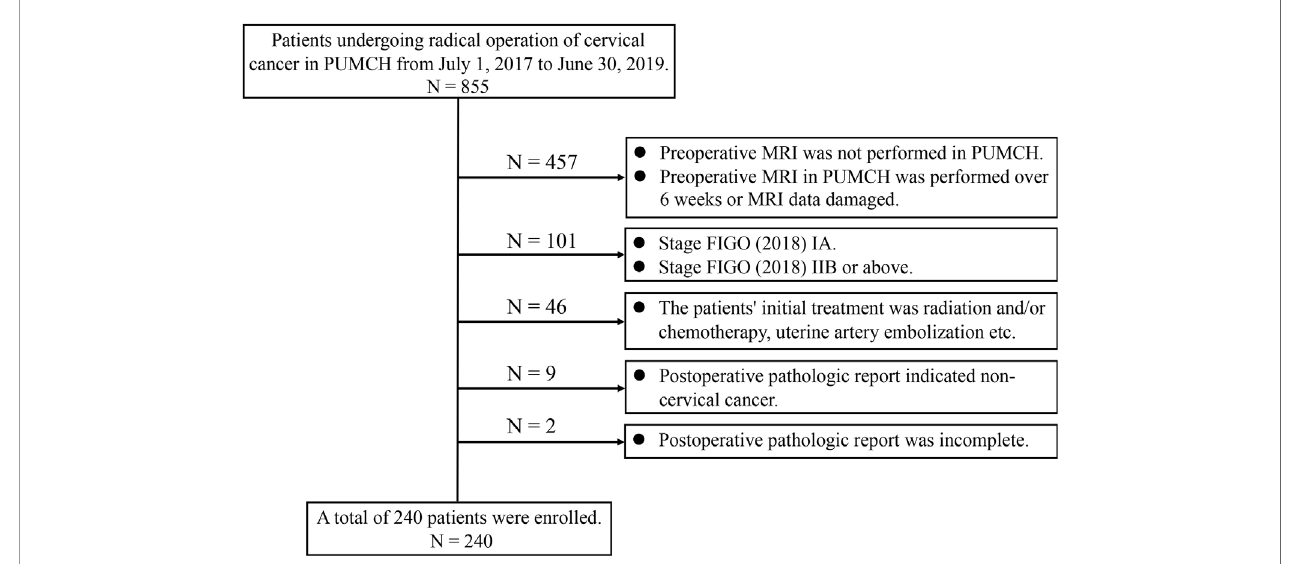
FIGURE 1 | Flow chart of enrolled patients. PUMCH, Peking Union Medical College Hospital; MRI, magnetic resonance imaging; FIGO, International Federation of Gynecology and